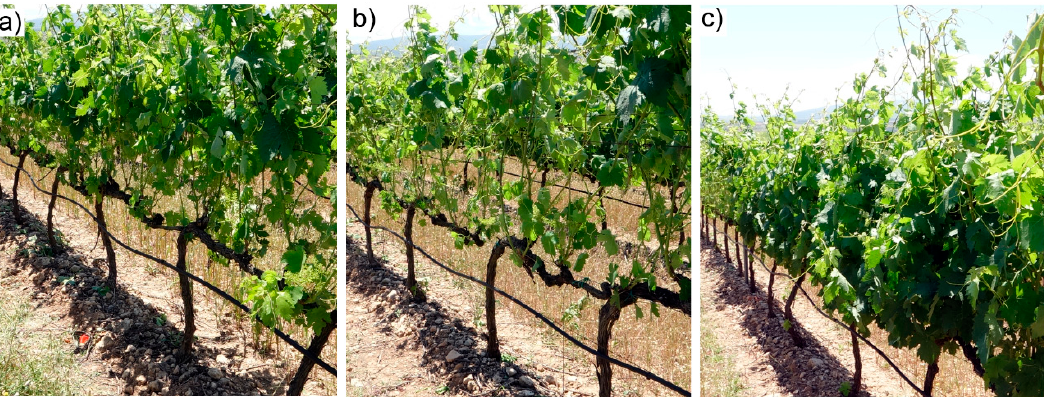
Figure 3. Pictures after leaf removal intensity experiment in Ausejo: a) low intensity leaf removal (LR- LI), b) high intensity leaf removal (LR-HI), c) control vines.